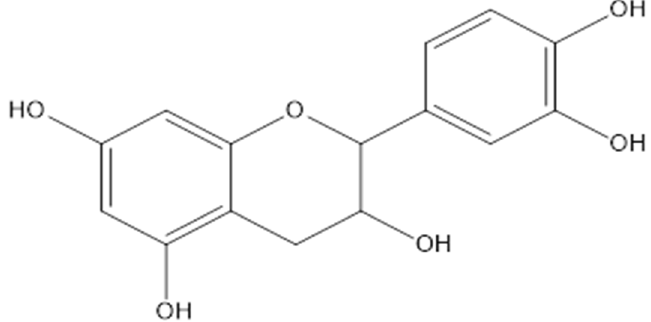
Figure 4. Chemical structure of epicatechin.